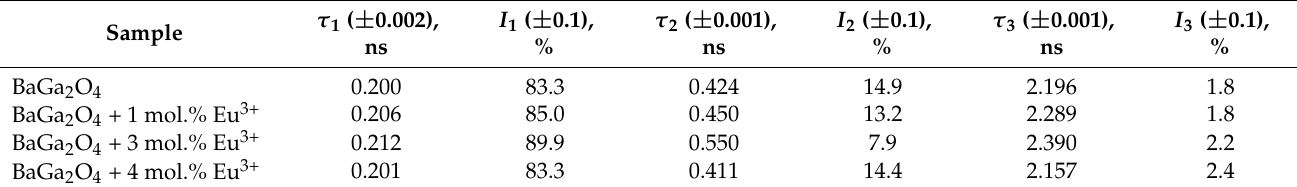
Table 3. Lifetimes and intensities for undoped and Eu 3+ -doped BaGa 2 O 4 ceramics obtained in three-component fitting procedure.